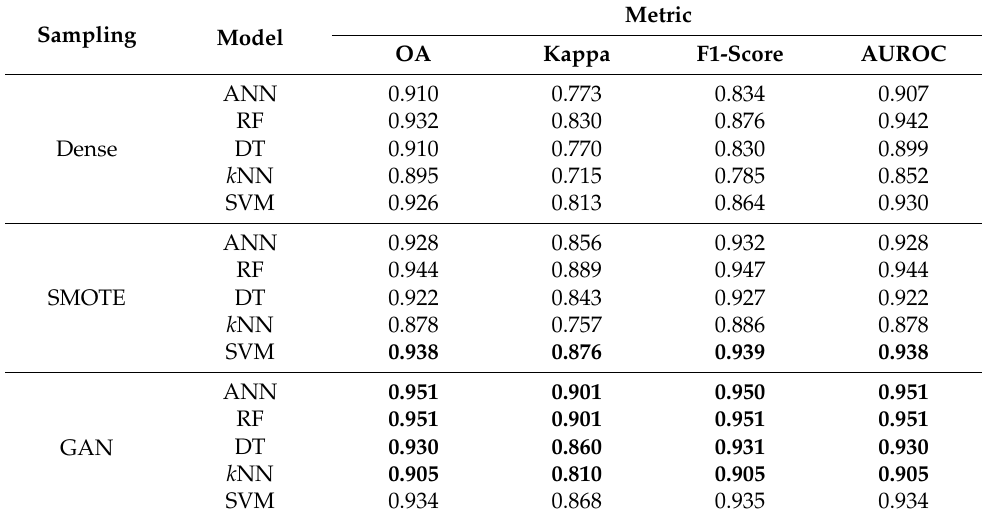
Table 6. Assessment of models with a dataset created based on a ratio of 1:3.